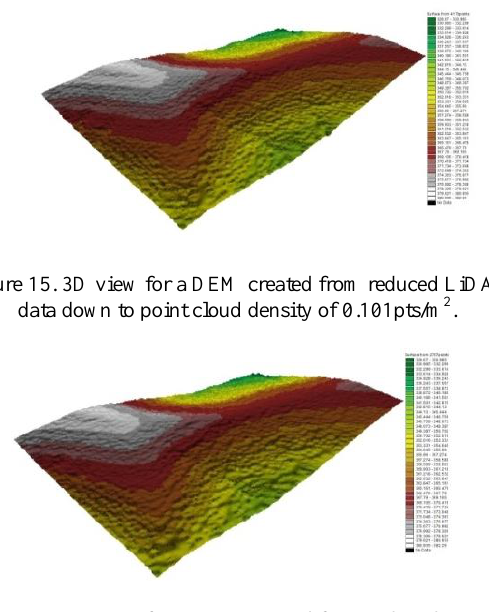
Figure 16. 3D view for a DEM created from reduced LiDAR data down to point cloud density of 0.067pts/m 2